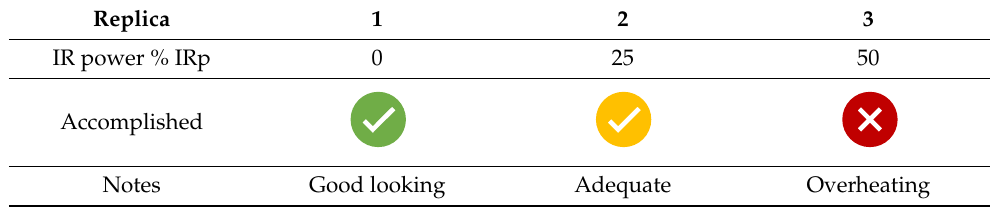
Table 7. Thermal process parameters summary.